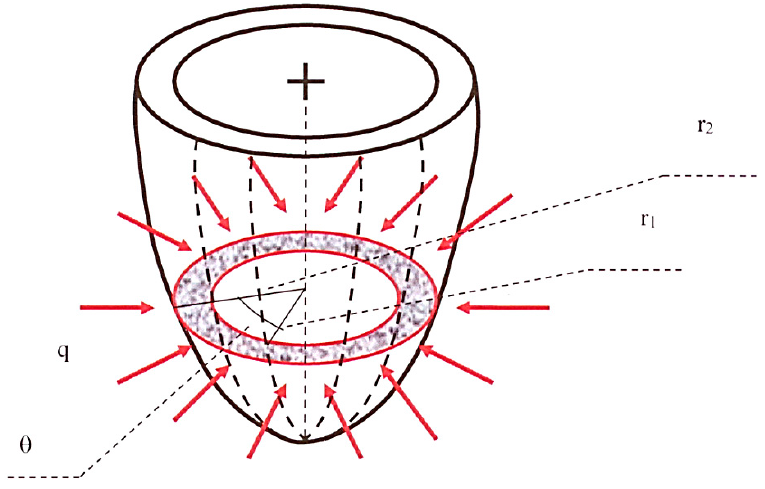
Figure 1. Sketch of the left ventricle